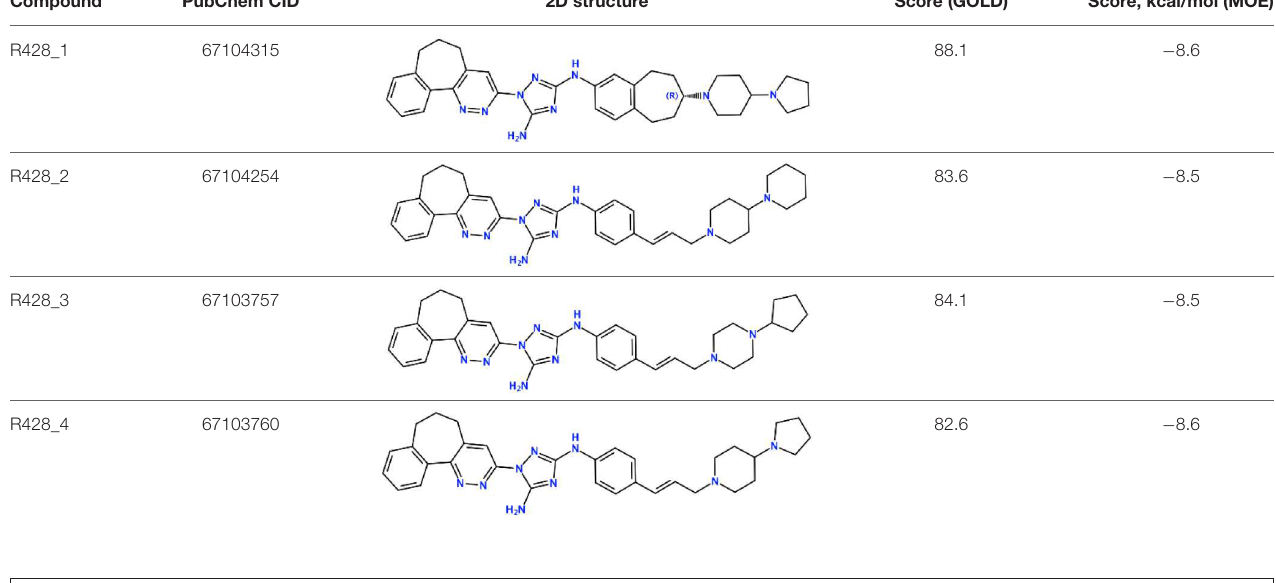
TABLE 3 | Four best R428 analogs according to the GOLD and MOE molecular docking scores. Compound